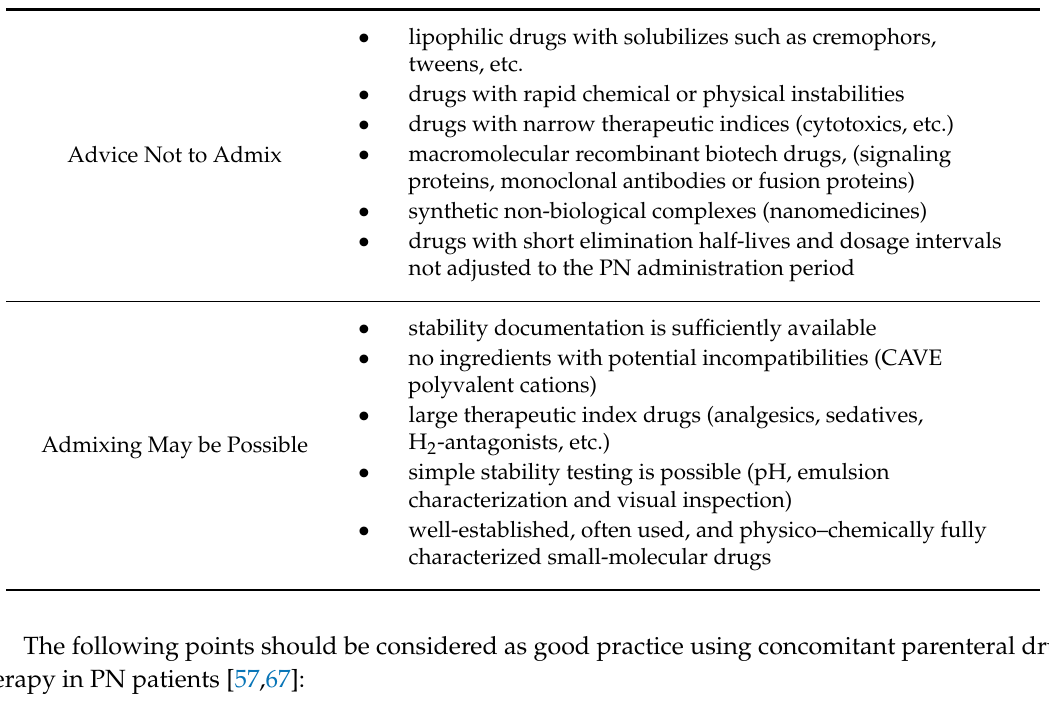
Table 3. Advices to the possible drug admixture to AiO PN